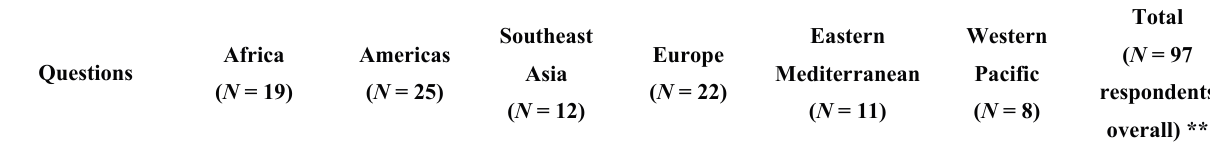
Table 1. Knowledge, Attitudes, and Beliefs about TPW, Framework Convention Alliance Survey, by WHO Region,